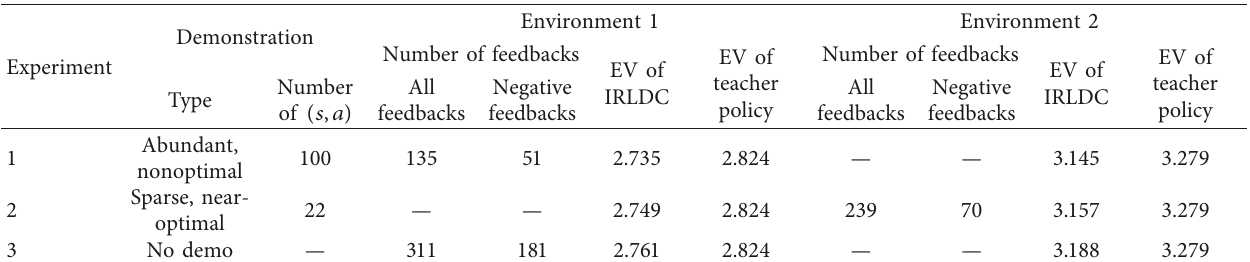
Figure 10: (a) and (b) E-puck robot navigating in two different environments. (c) E-puck external camera perspective used to localize its position. Table 4: Results of the learned navigation experiment by the E-puck robot in two different environments, with M � 30 interaction steps with the environment before the learner policy is updated. Here, in experiments 1 and 3, demonstrations and feedbacks are provided in the same environment, and then, the performance of the learned reward function is examined in the second environment. Experiment 2 is done by providing sparse demonstrations in one environment and feedbacks in